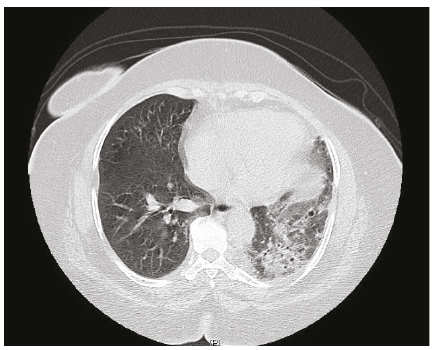
Figure 1: Axial CT of the chest with consolidative changes to the left lung and hypertrophied bronchial arteries.